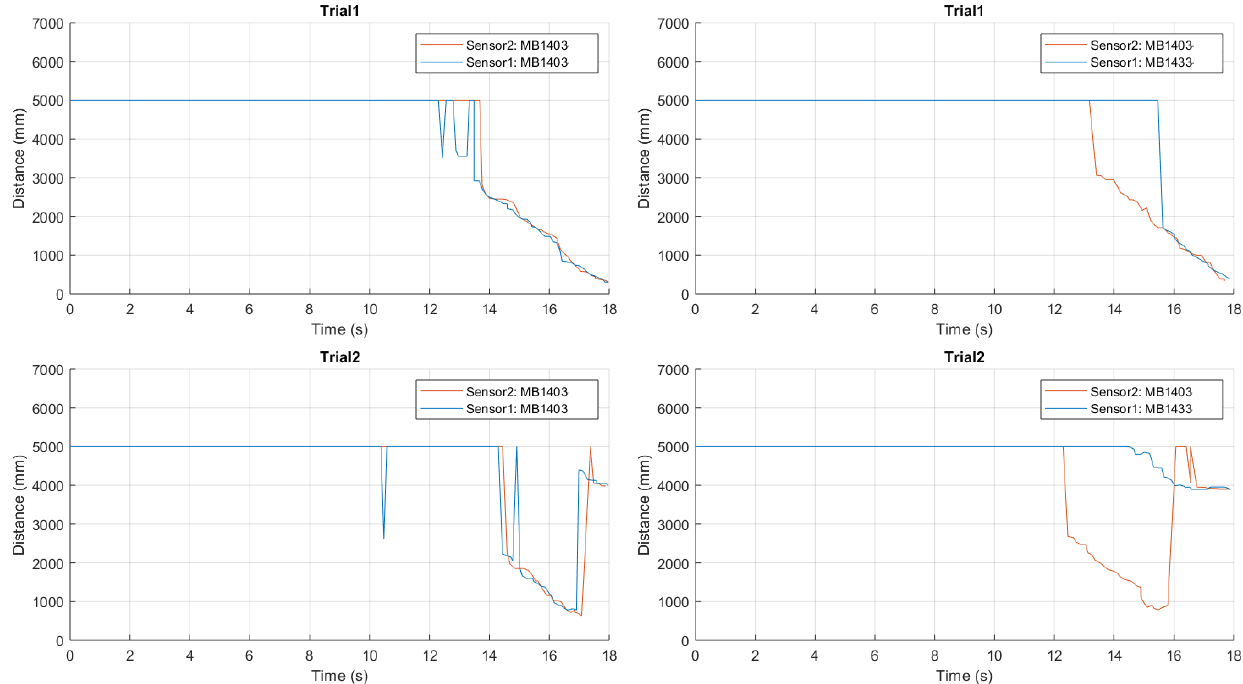
Figure 15. Experimental distance estimates collected with the configuration composed by two adjacent ultrasonic sensors pointing forward, and in presence of a vertical stake-shaped